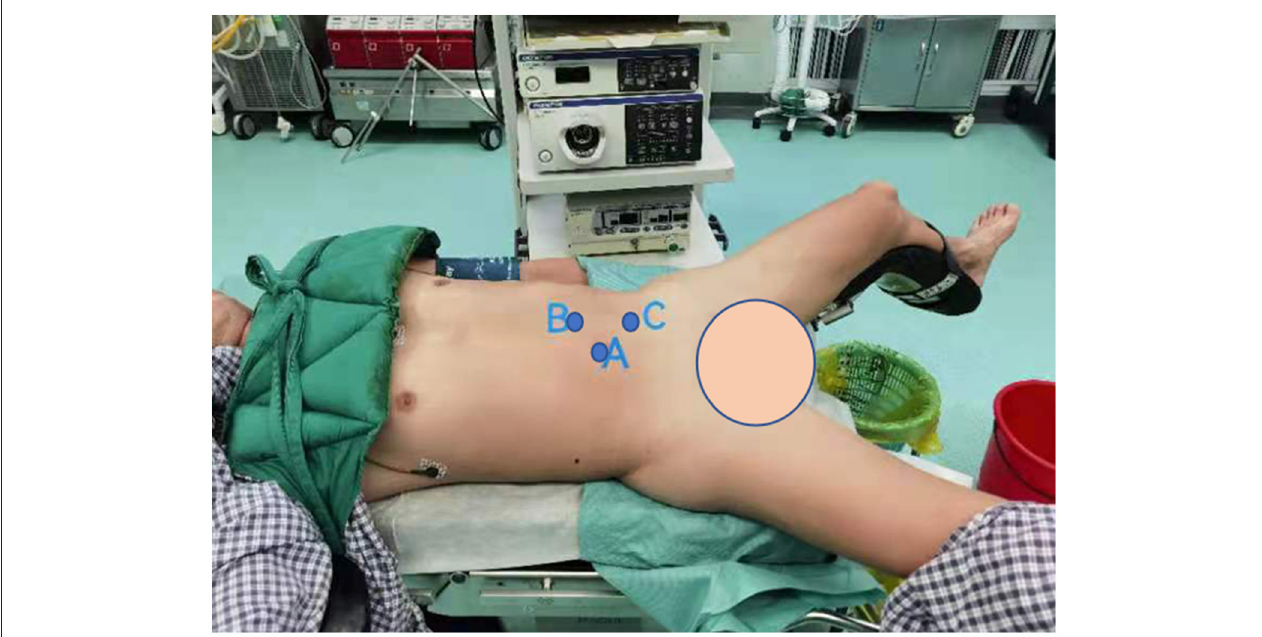
FIGURE 2 | Multiple polyps in the ureteral lumen are seen under the ureteroscope ( a–c , red arrow). The ureteroscopy light source can be clearly seen under the laparoscope ( d , red arrow).